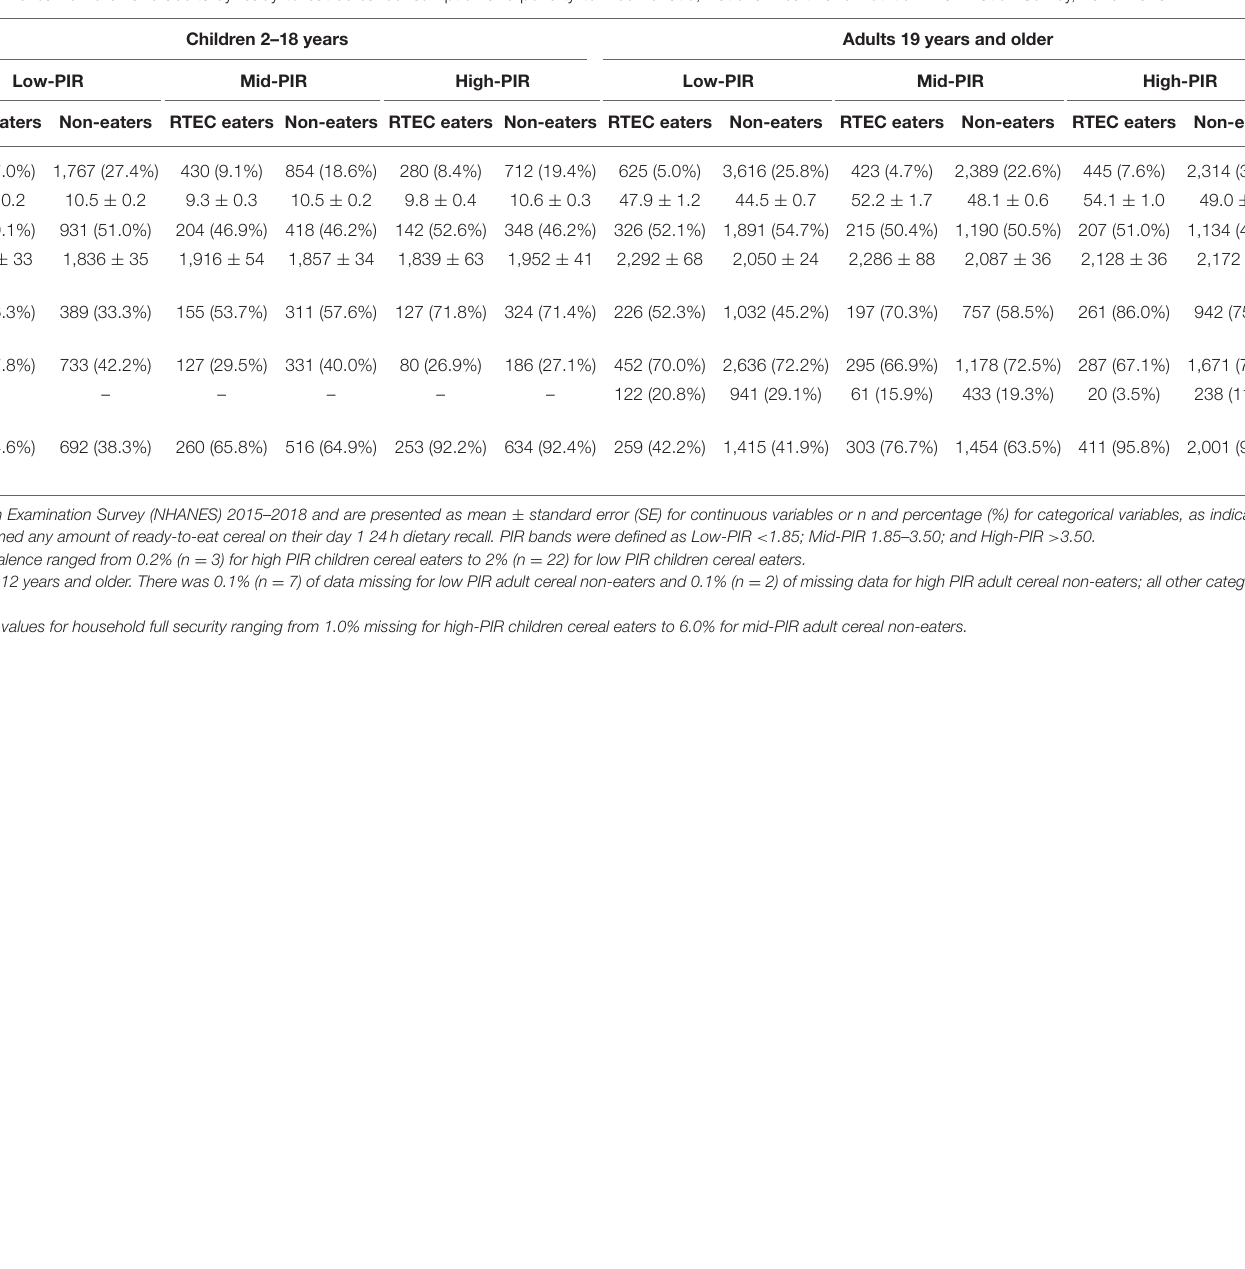
TABLE 1 | Demographic characteristics for American children and adults by ready-to-eat cereal consumption and poverty-to-income ratio, National Health and Nutrition Examination Survey, 2015–2018 a